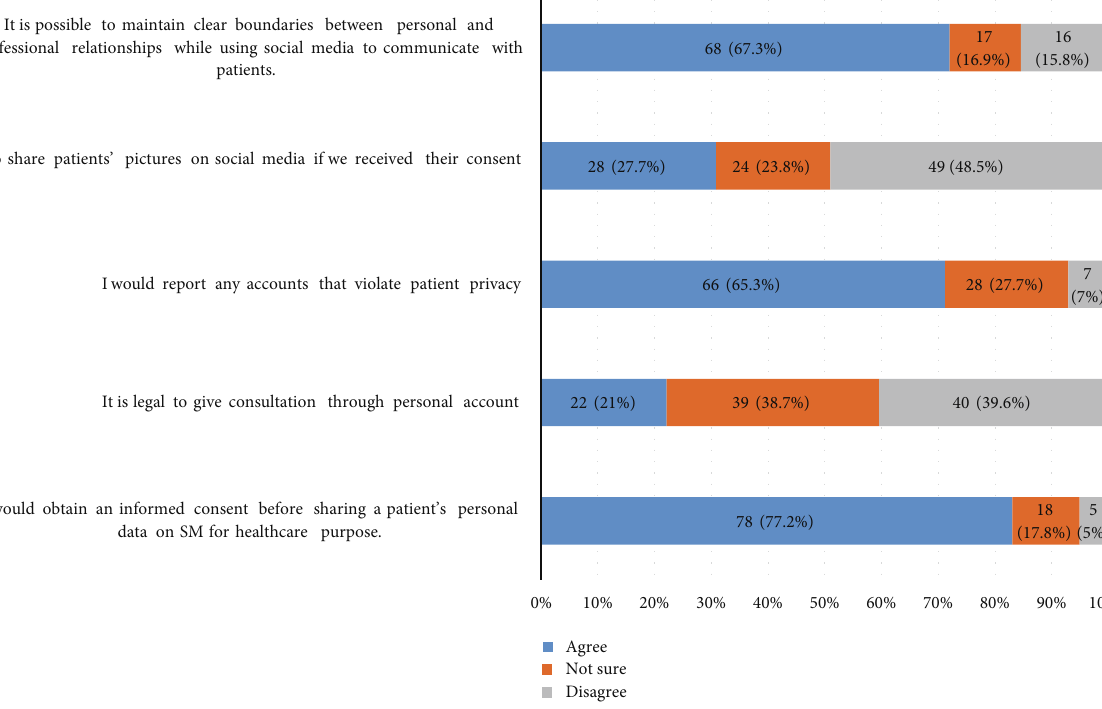
Figure 3: Patient privacy and con fi dentiality on social media